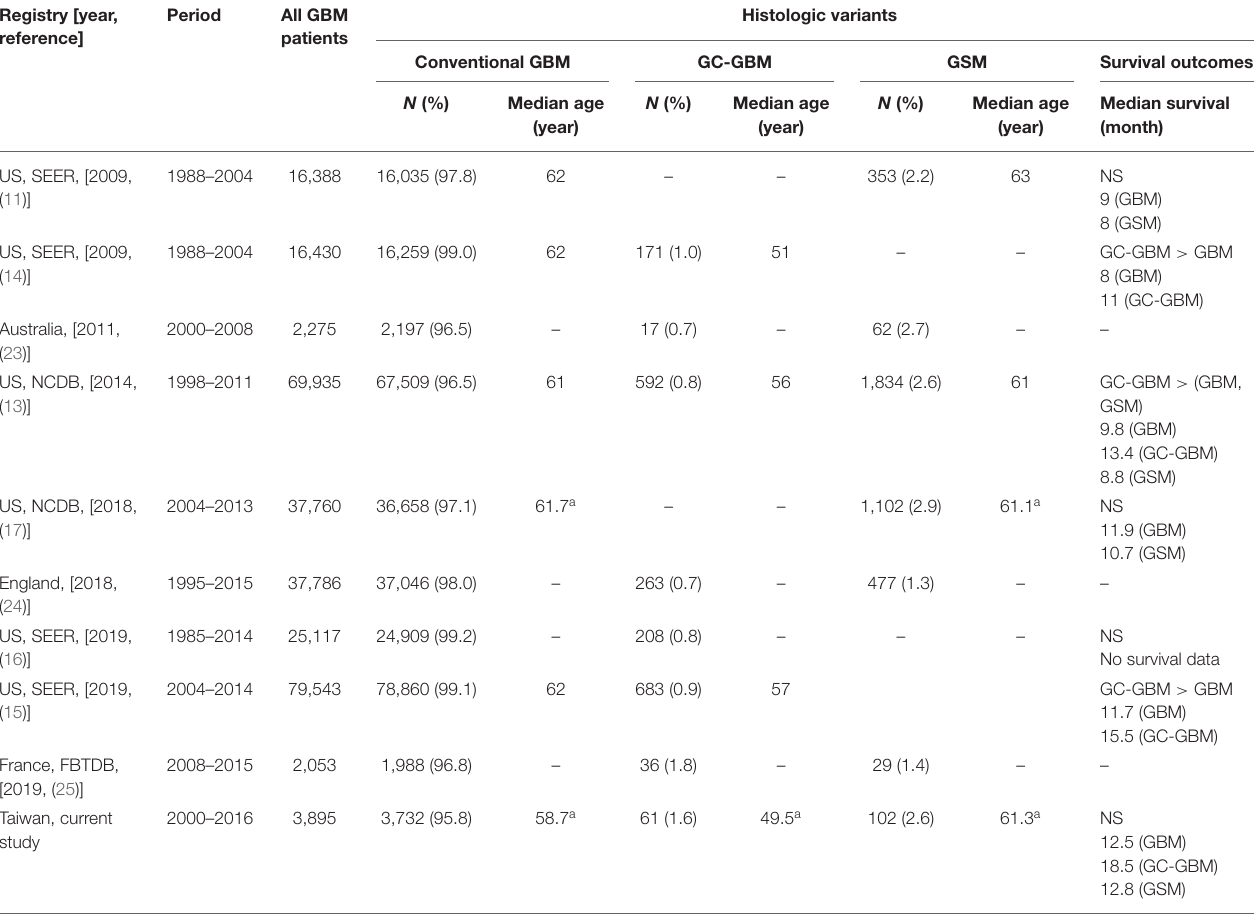
TABLE 4 | Literature review on the epidemiologic data on histologic variants of glioblastoma from population-based cancer registries. Registry [year,